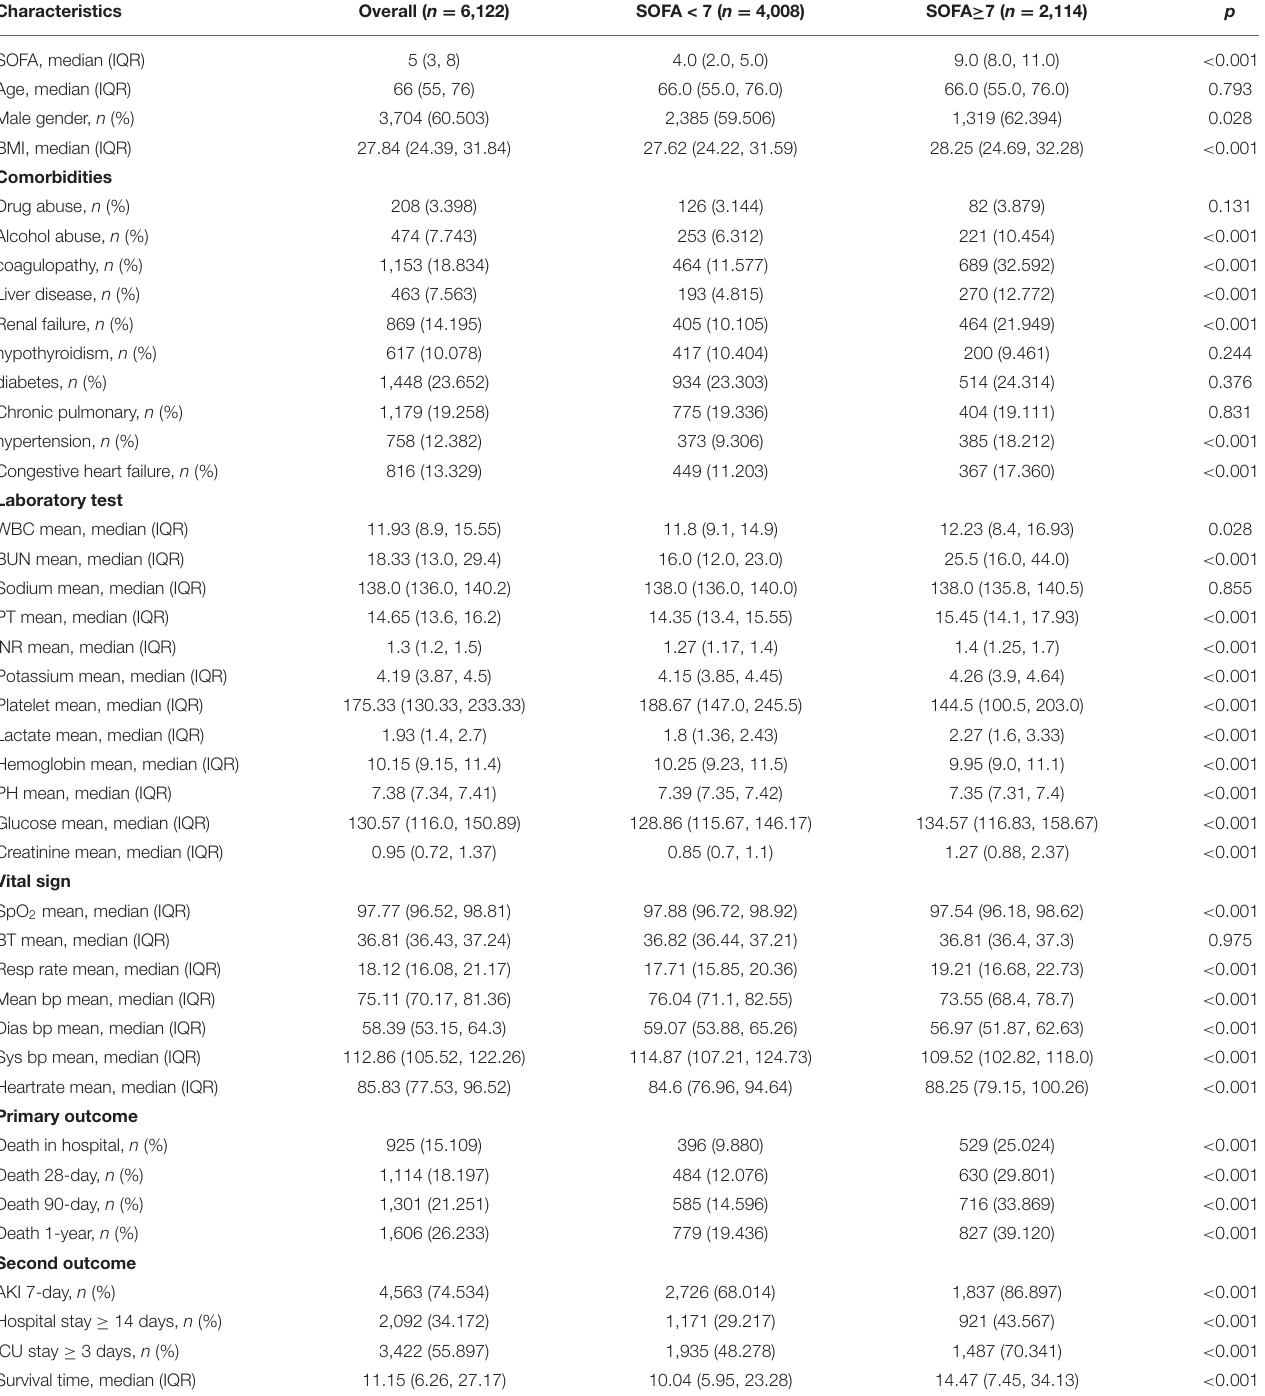
TABLE 2 | Basic characteristics of SOFA scoring